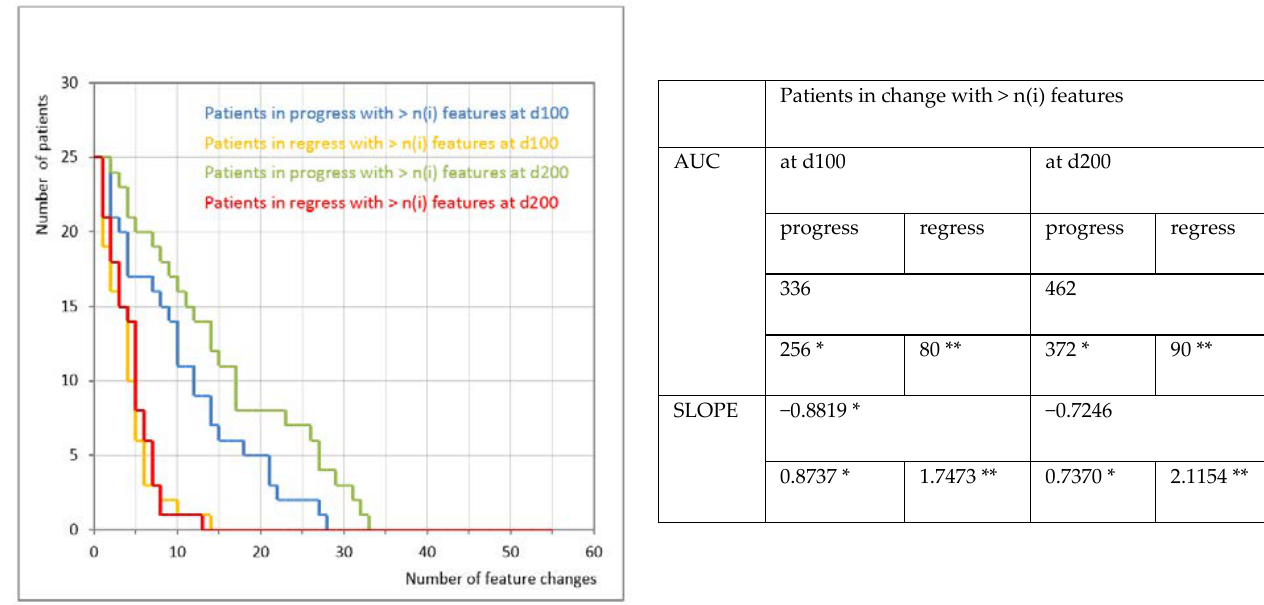
Figure 2. Clinical and psychological feature dynamics of patients. Positive (green) and negative (orange, red) feature changes at day 100 (d100, dotted lines) and day 200 (d200, solid lines) of the methylcobalamin treatment. * More positive or bigger value is better. ** Less positive or lesser value is better.